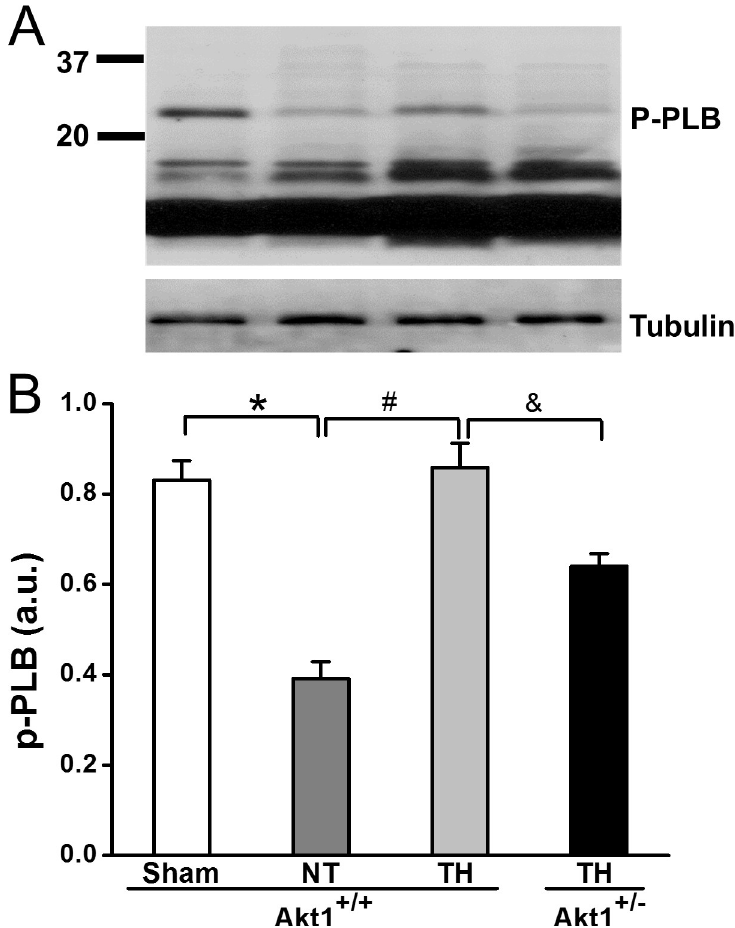
Fig 4. Phospholamban phosphorylation was analyzed by Western blot at R30 in hearts of Akt1 +/- and Akt1 +/- mice with TH treatment. Tubulin was used as a loading control. � p < 0.05 between sham and NT groups of Akt1 +/+ ; # p < 0.05 between NT and TH groups of Akt1 +/+ ; & p < 0.05 between TH-treated groups of Akt1 +/+ and Akt1 +/- mice. Data presented are means ± SEM of four